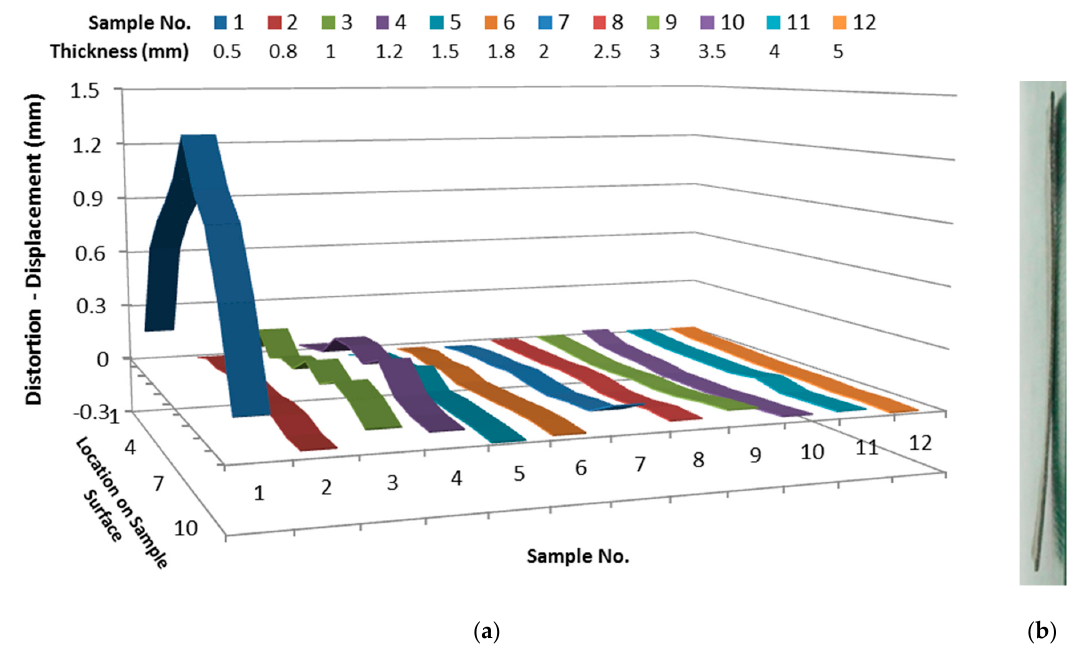
Figure 8. ( a ) The distortion profile is showing that it is decreasing with increasing sample thickness. ( b ) A sample showing distortion.